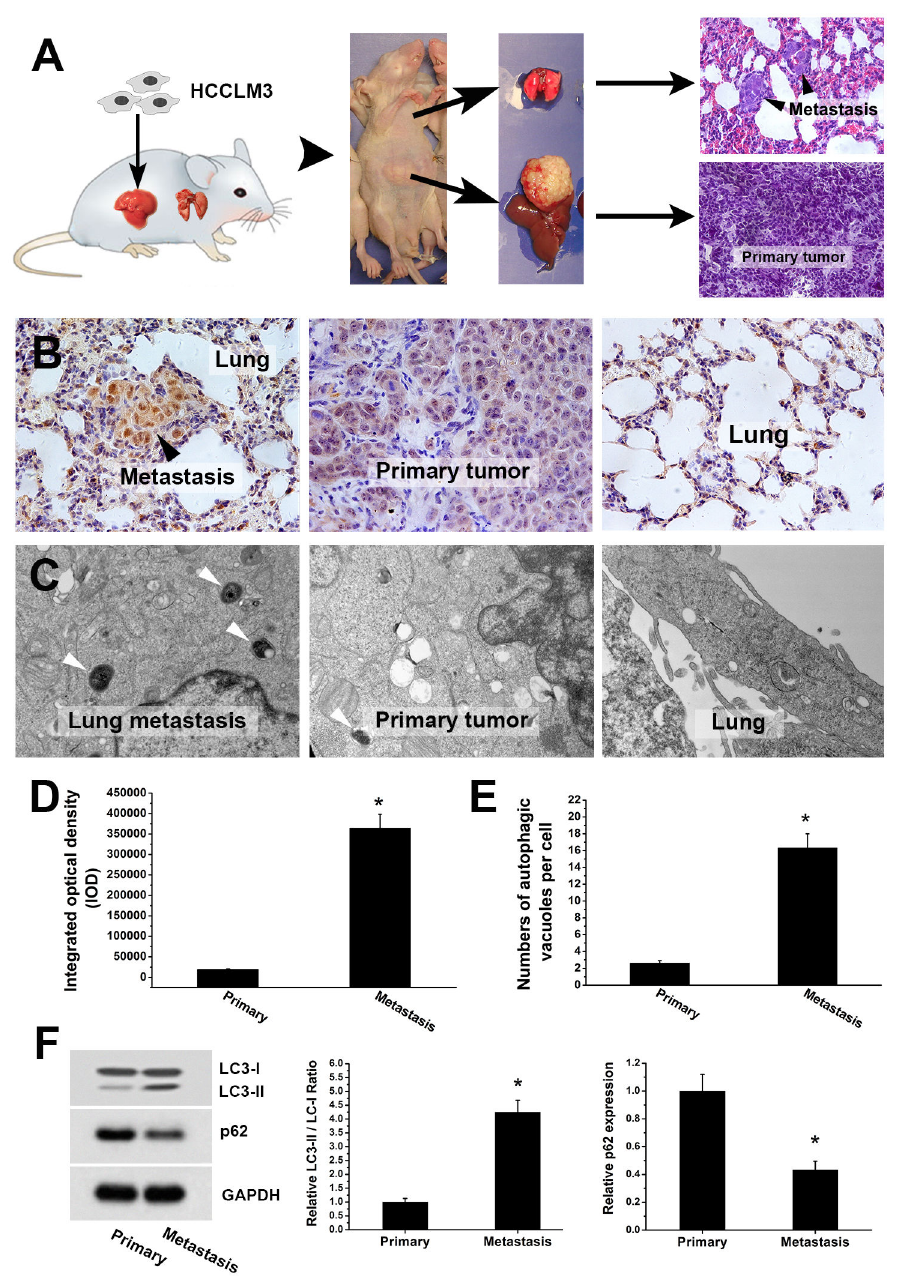
Figure 2. Immunohistochemical analysis, transmission electron microscopy and western blot analysis of lung metastases and paired primary HCC tumors from mouse model of pulmonary metastasis. (A) Establishment of mouse model of pulmonary metastasis using highly metastatic HCC cell line (HCCLM3). (B, D) Immunohistochemical analysis of LC3 expressions in lung metastases and paired primary tumors showed higher LC3 expression in lung metastases. (C, E) Transmission electron microscopic analysis of lung metastases and paired primary HCC tumors revealed increased autophagic vacuoles in lung metastases. White arrows point to autolysosome and autophagosome. (F) Western blot analysis showed significantly increased LC3II/LC3I ratio and remarkably decreased p62 level in lung metastases (* P <0.05).